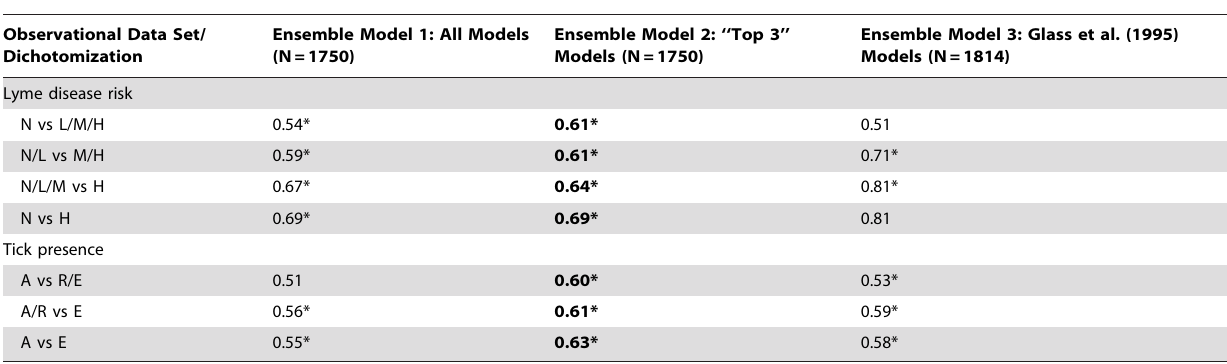
Table 5. AUC values from MLR analyses for predictive models using CDC data as gold standard – ensemble models.